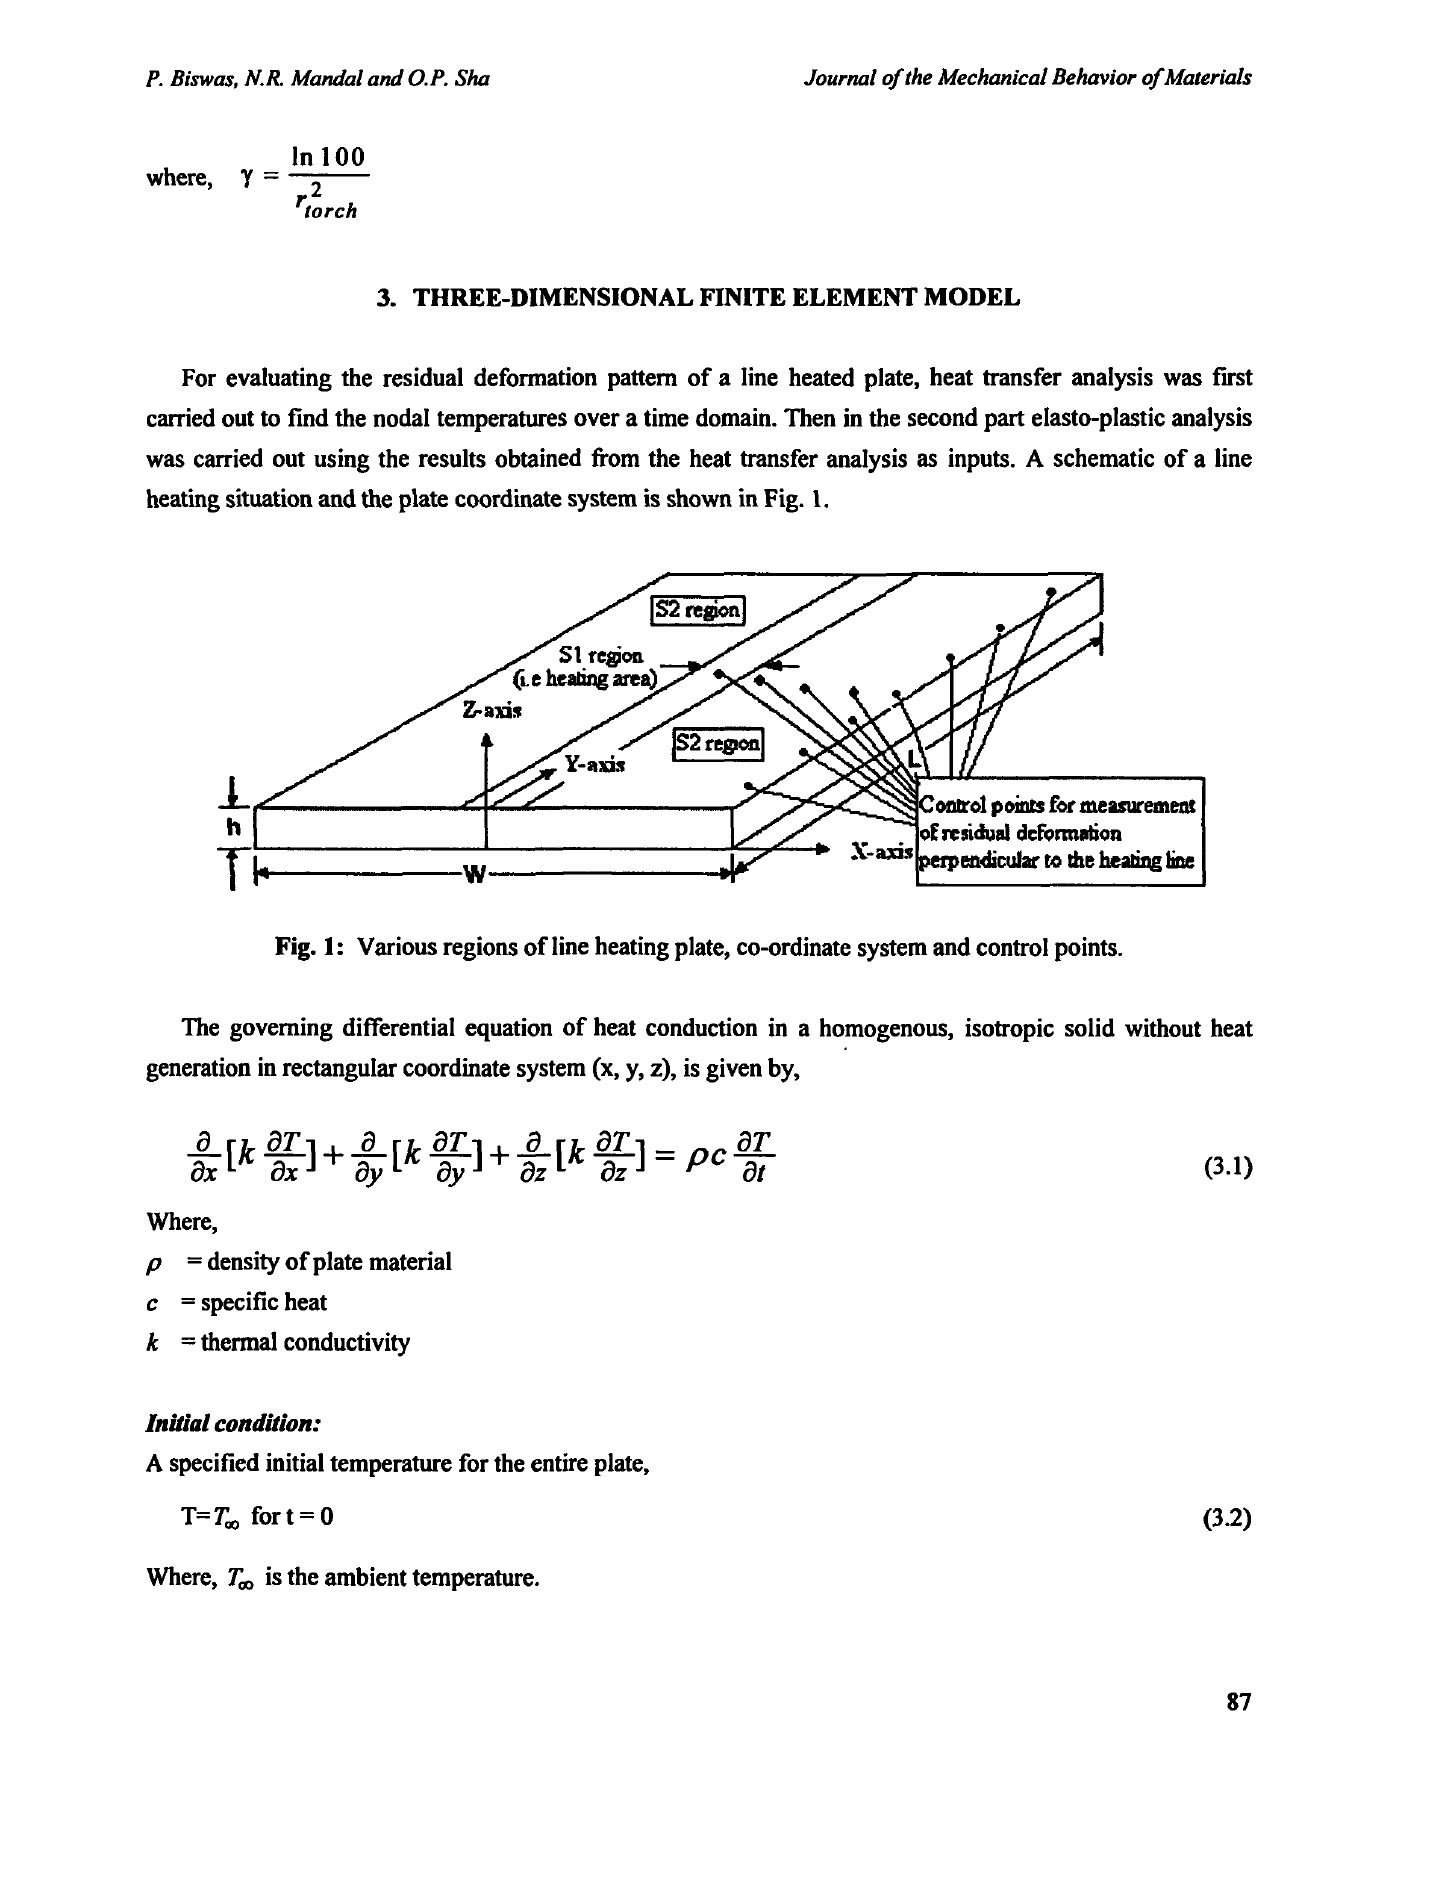
Fig. 1: Various regions of line heating plate, co-ordinate system and control